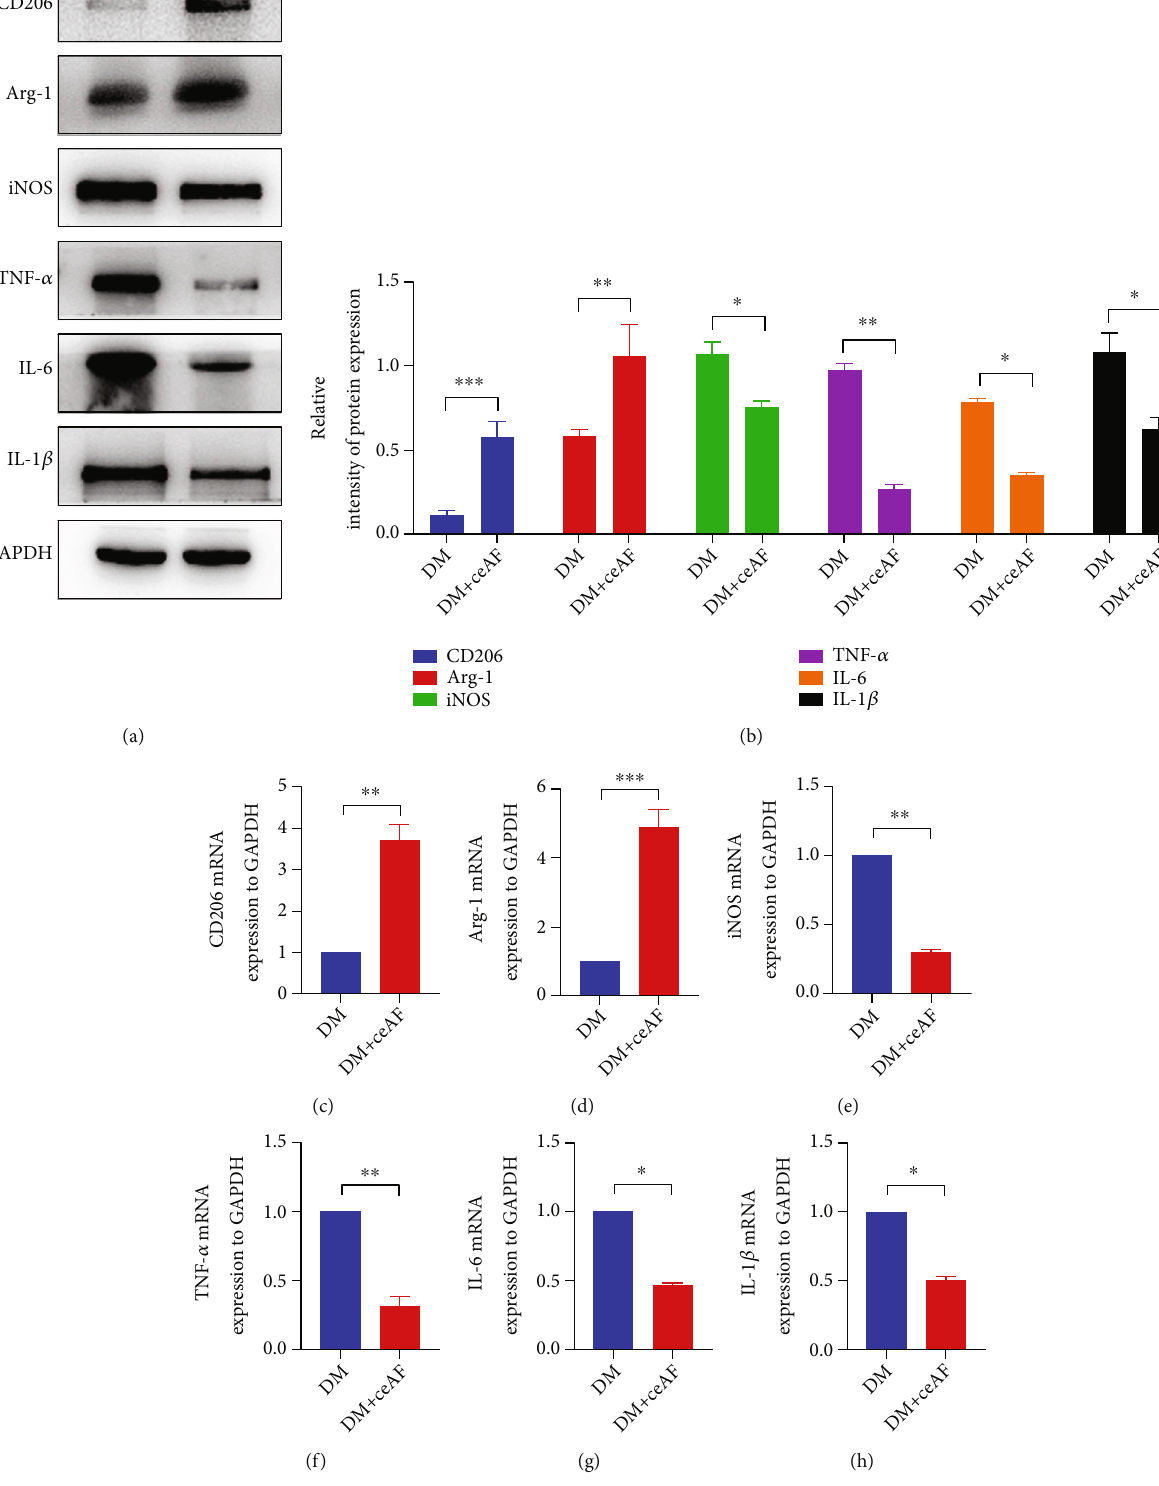
Figure 6: ceAF was able to suppress in fl ammation via promoting M2 macrophage polarization in vivo . (a) The expression of CD206, Arg-1, iNOS, IL-1 β , IL-6, and TNF- α in the diabetic wound of mice was evaluated by WB. GAPDH served as a standard reference. (b) WB blots in (a) were quanti fi ed by densitometric analysis. (c – h) The expression of CD206, Arg-1, iNOS, IL-1 β , IL-6, and TNF- α in the diabetic wound of mice was tested by RT-qPCR. n = 6 , Mean ± SEM . ∗ P < 0 : 05 , ∗∗ P < 0 : 01 , ∗∗∗ P < 0 : 001